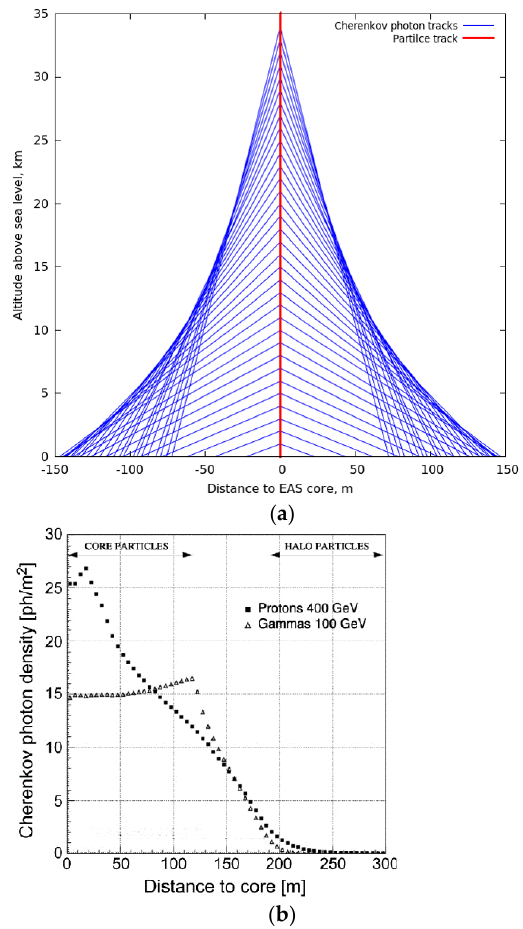
Figure 2. ( a ) Lateral distribution of Cherenkov light emission from a single relativistic muon traversing the atmosphere. The observation height is 600 m a.s.l. One can see the light focusing effect (the “hump”) on the ground, at 70–130 m distance from the core. Image courtesy V. Samoliga. ( b ) The lateral distribution of Cherenkov light from a 100 GeV gamma and 400 GeV proton. One can see the “hump” at about 125 m distance from the shower axis (observation height 2.2 km a.s.l.). The “core particles” and the “halo particles” are meant to show the impact parameter range where the light arrives from high and low altitudes in the shower development, respectively.